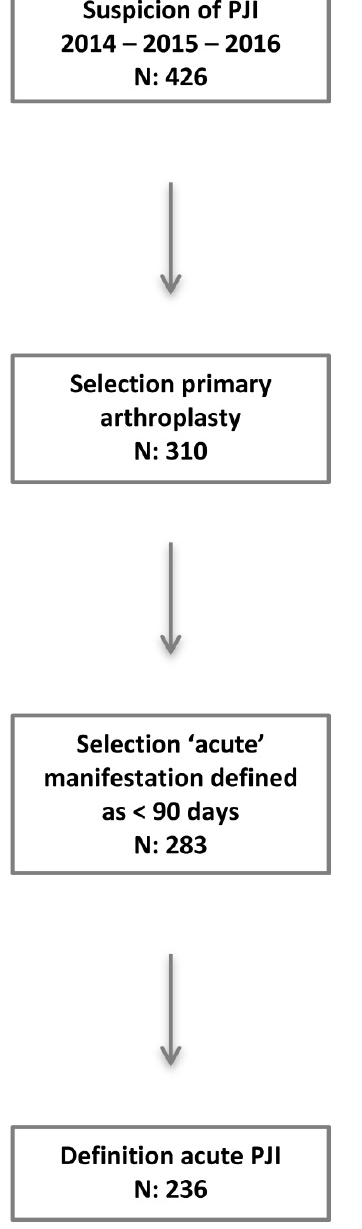
Figure 2. Flow chart patient